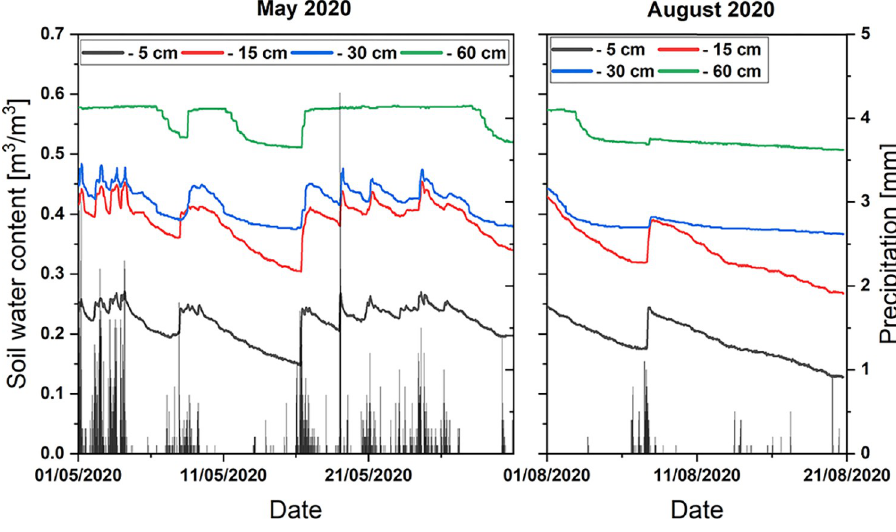
Fig 3. Soil water content at 1980 m a.s.l. in the research area at various soil depths over a wet (May 2020) and 3 weeks of an exceptionally dry month (August 2020). The vertical bars represent precipitation events of different